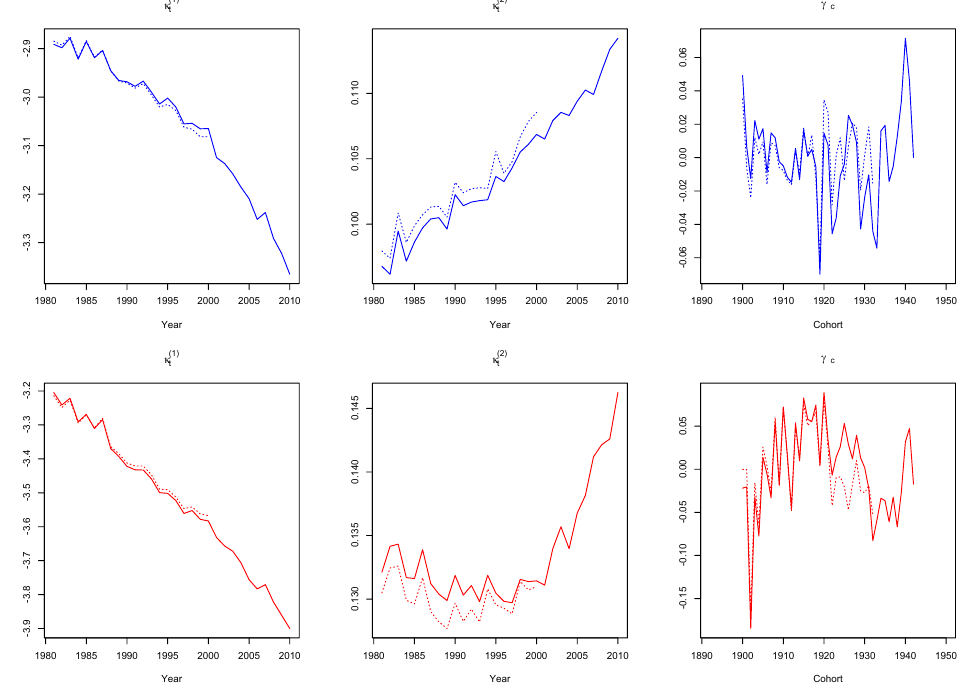
( 1 ) ( 2 ) Figure 6. M 6 : κ , κ and γ c estimated parameters for males ( top panels) and females ( bottom t t panels), aged 60–89, fitted in 1981–2010 (solid lines) and 1981–2000 (dotted